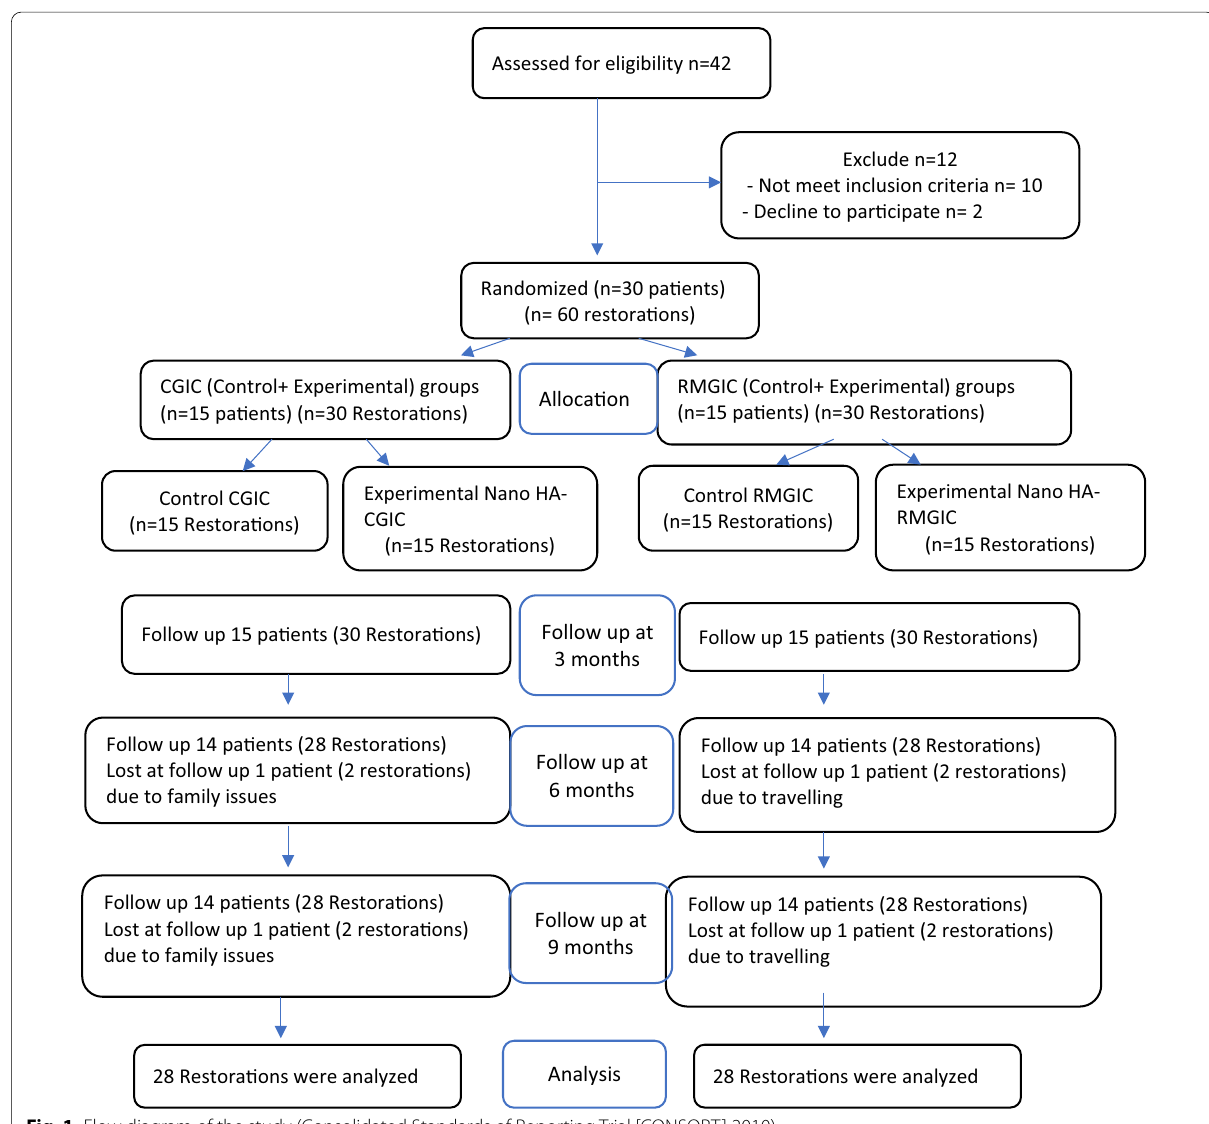
Fig. 1 Flow diagram of the study (Consolidated Standards of Reporting Trial [CONSORT]